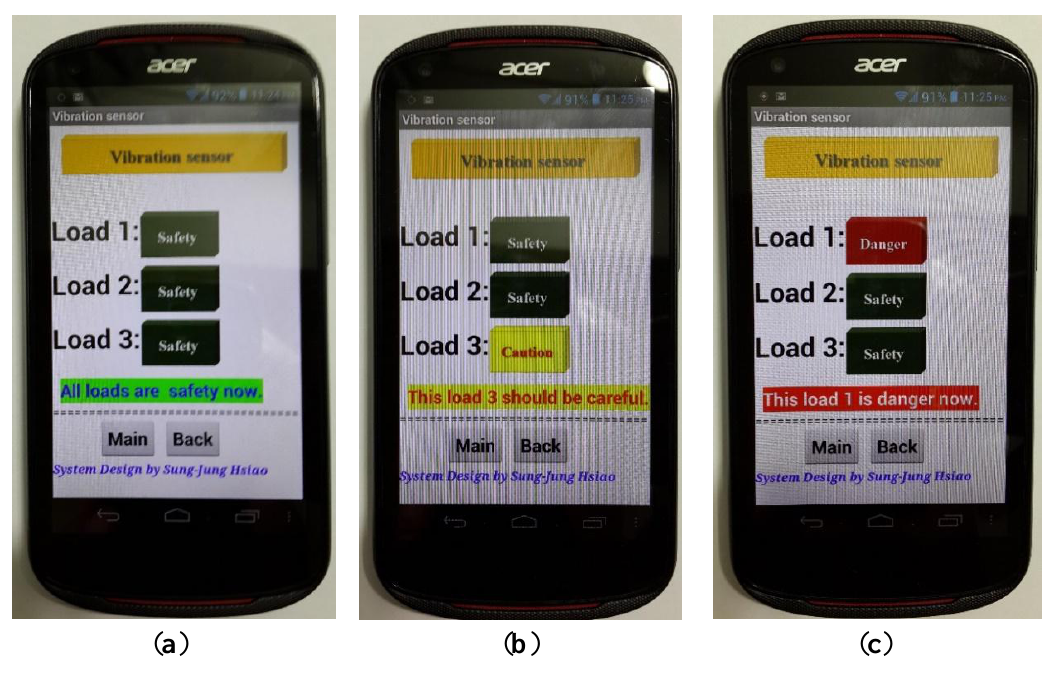
< 80 mV; detection